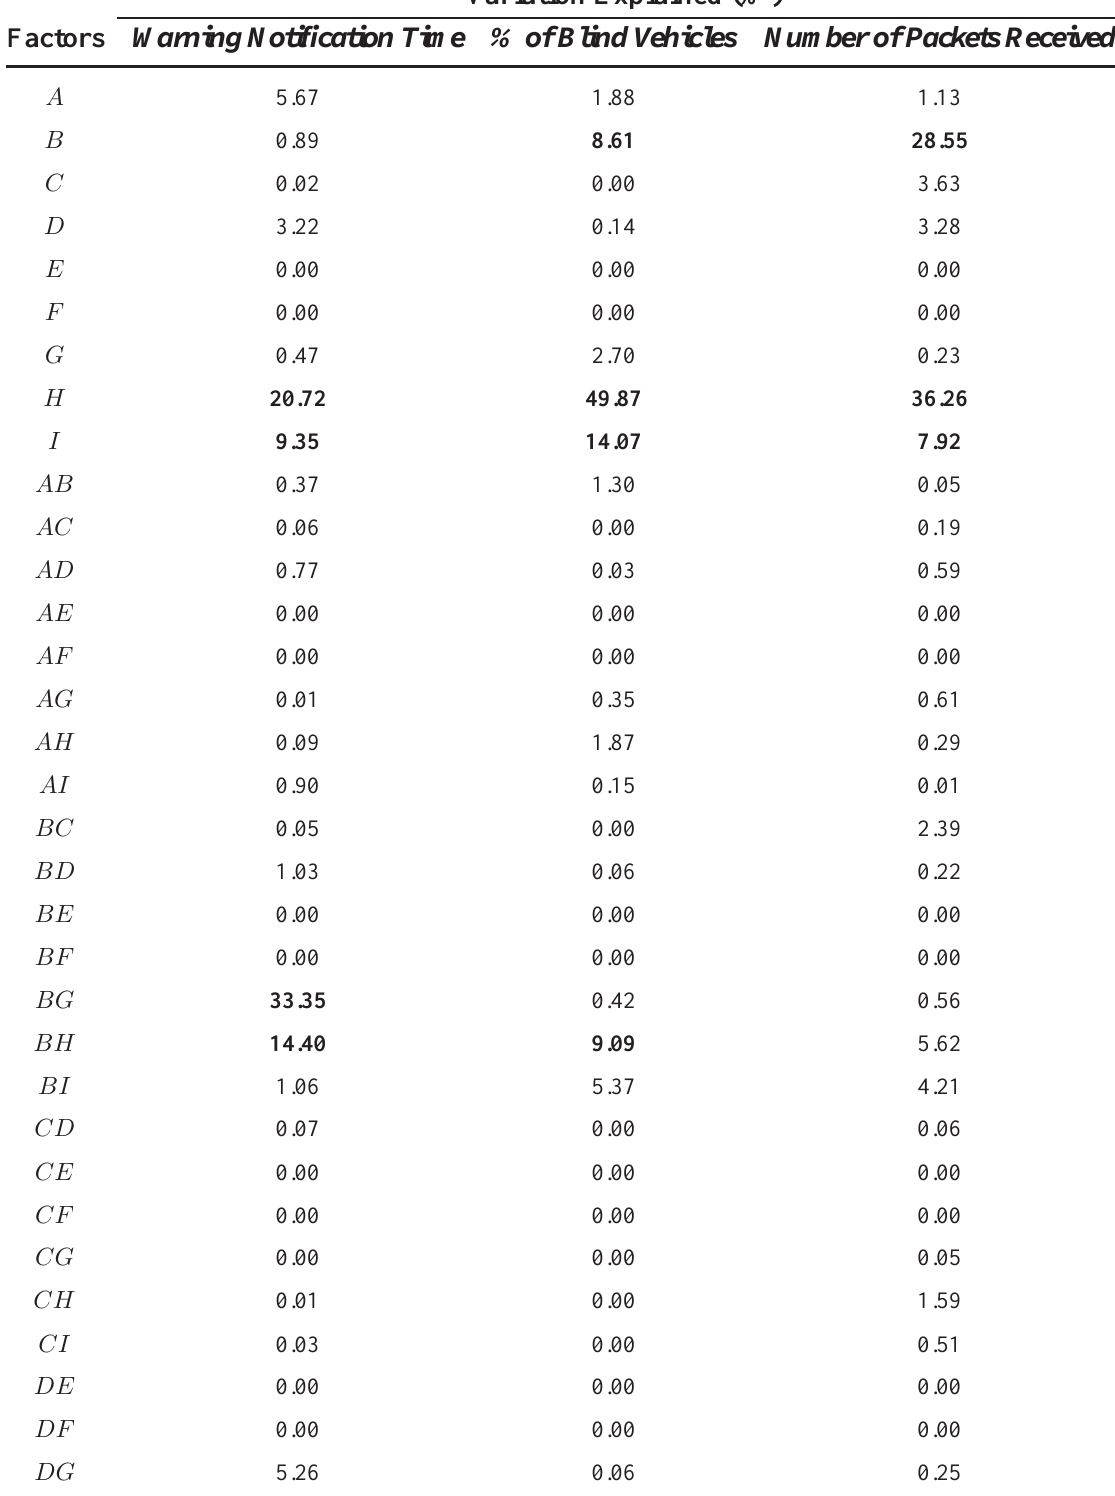
Table 6. The percentage of variation explained using the sign table method up to the combination of 2 factors. Highlighted values indicate representative